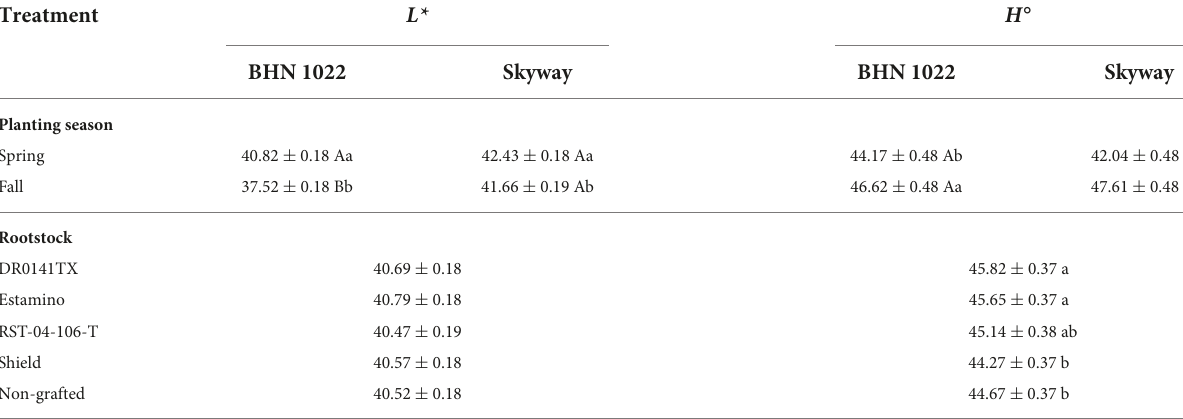
TABLE 2 Fruit L * (lightness) and H ◦ (hue angle) values of fruit from grafted beefsteak tomato ‘Skyway’ and grape tomato ‘BHN 1022’ in Spring and Fall plantings. Treatment